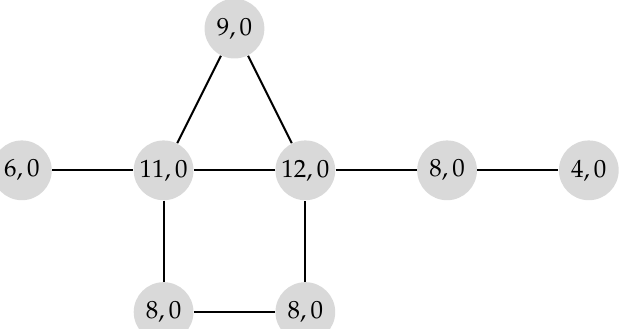
Figure 2. Graph G at line 5 of the Algorithm